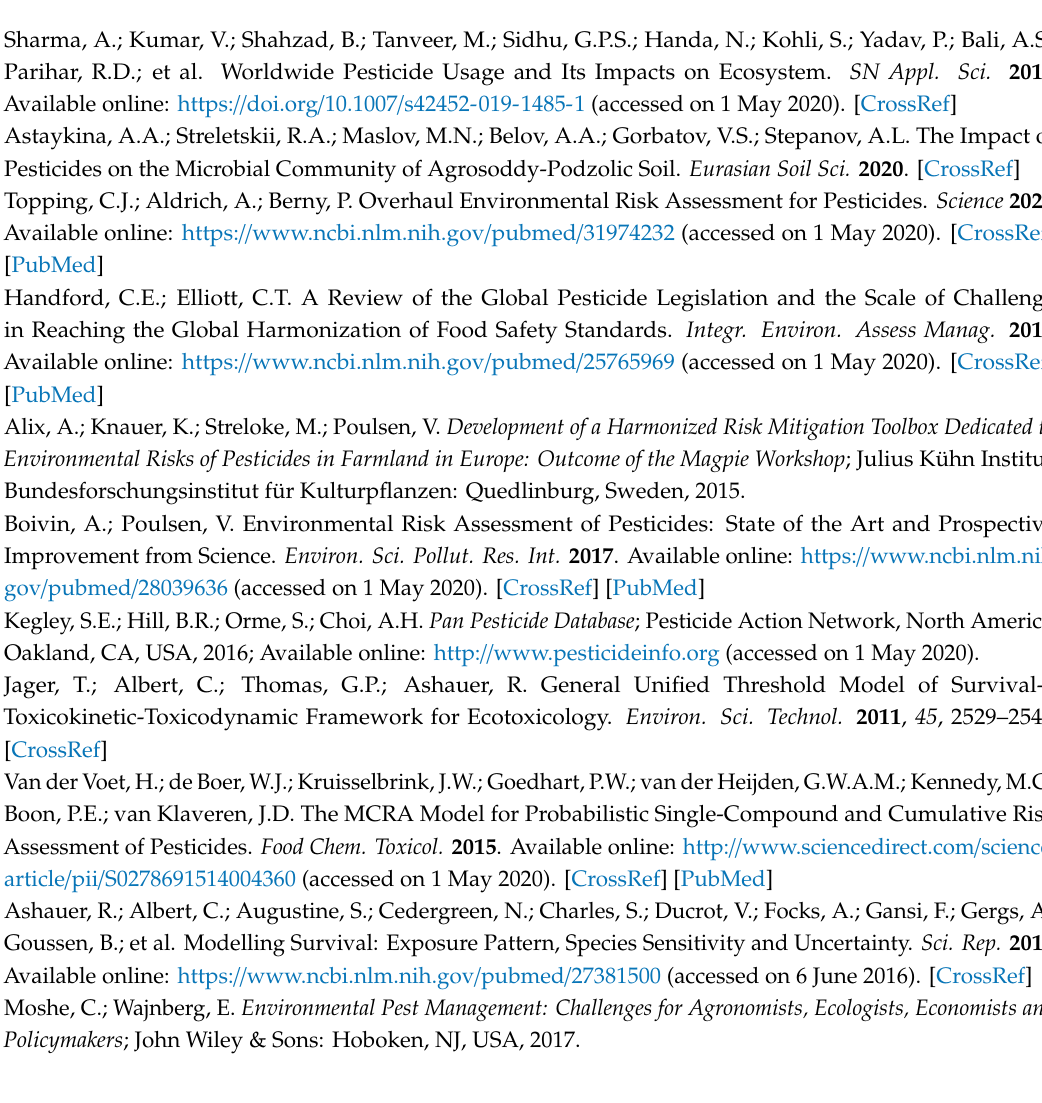
Table S1: Parameters of the soddy–podzolic soil, Table S2: Physicochemical and eco-toxicological properties of pesticides, Table S3: Metribuzin residual amount in soddy–podzolic soil, Table S4: PEC in soil and surface